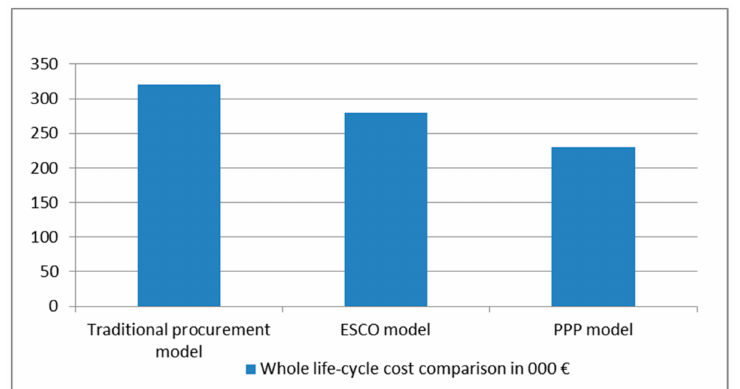
Figure 2. Example of Value-for-Money analysis. Source: Value-for-Money analysis in PPP projects (Manual no. 6,